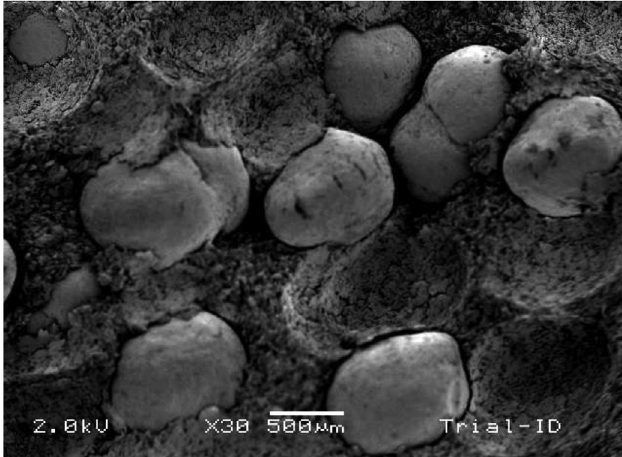
FIGURE 6 - Scanning electron micrograph of compressed tablet indicating distribution of matrix pellets within the diluent blend .